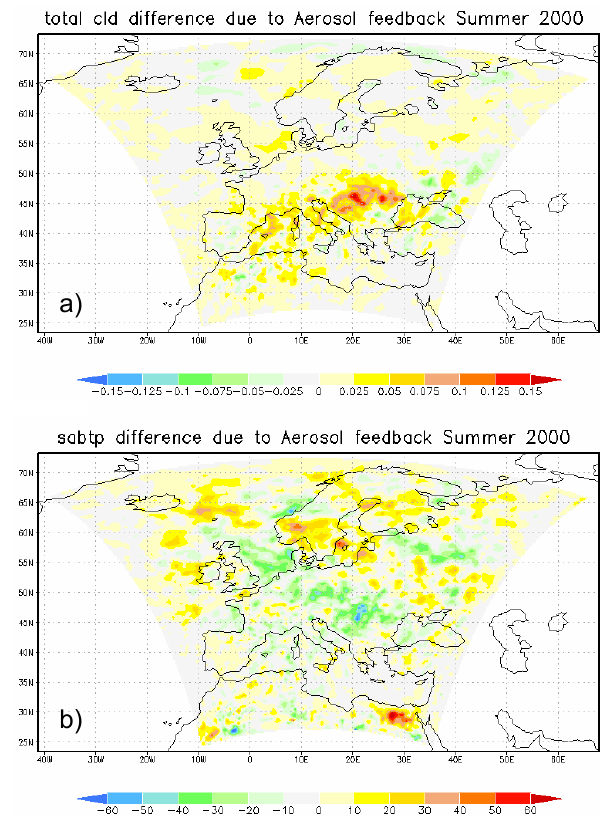
Figure 5. Seasonal mean fields in summer for the year 2000 of the difference AFrun-Crun Fig. 5. Seasonal mean fields in summer for the year 2000 of the RegCM3/aerosol simulations due to aerosol feedback in a) total column fractional cloud difference AFrun-Crun RegCM3/aerosol simulations due to aerosol cover (%) and b) surface absorbed solar radiation (W/m 2 ). The total column fractional feedback in (a) total column fractional cloud cover (%) and (b) sur- face absorbed solar radiation (W/m 2 ) . The total column fractional cloud cover denotes the percent coverage by clouds for the total column at each grid cloud cover denotes the percent coverage by clouds for the total col- point taking into account the fractional cloud cover for each model level. umn at each grid point taking into account the fractional cloud cover for each model